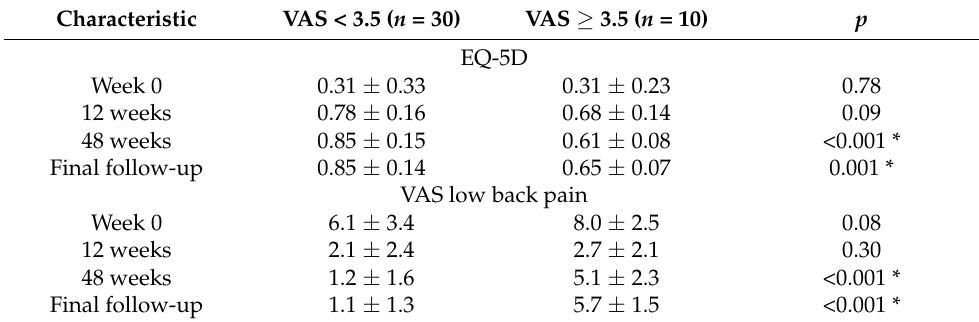
Table 2. Patient-reported outcome measures.